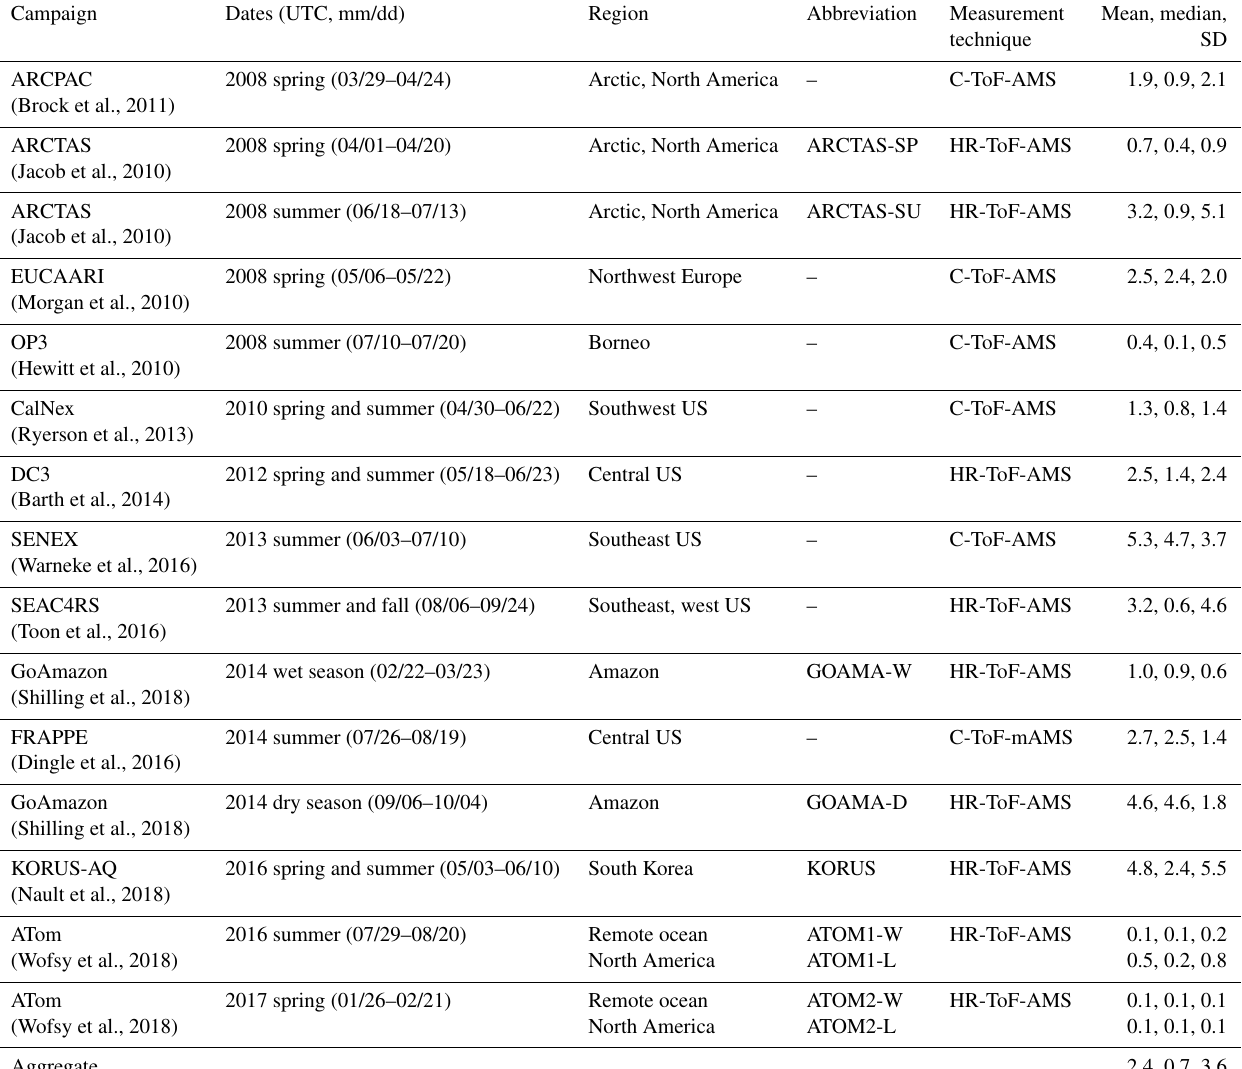
Table 3. Aircraft measurements of organic aerosol used in this analysis. The statistical metrics for OA provided here (mean, median, standard deviation) are based on filtered data for each campaign (as discussed in the text; units: µg m − 3